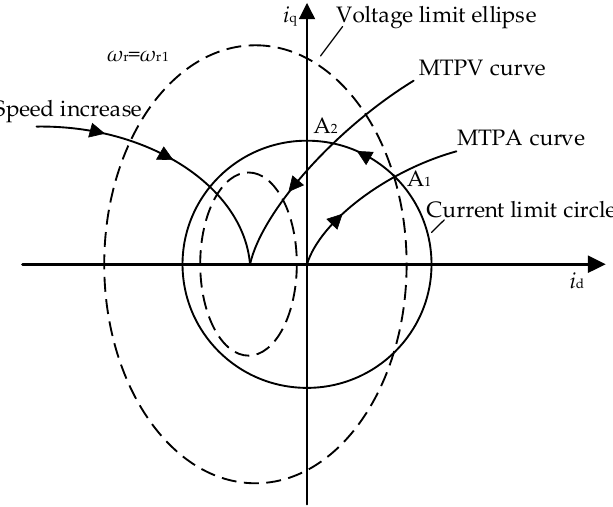
Figure 7. The limit curves and stator current distribution of resonant wireless EESM (RW-EESM) The rotor excitation current is controlled to a constant value. At different speeds, the stator current can be controlled as